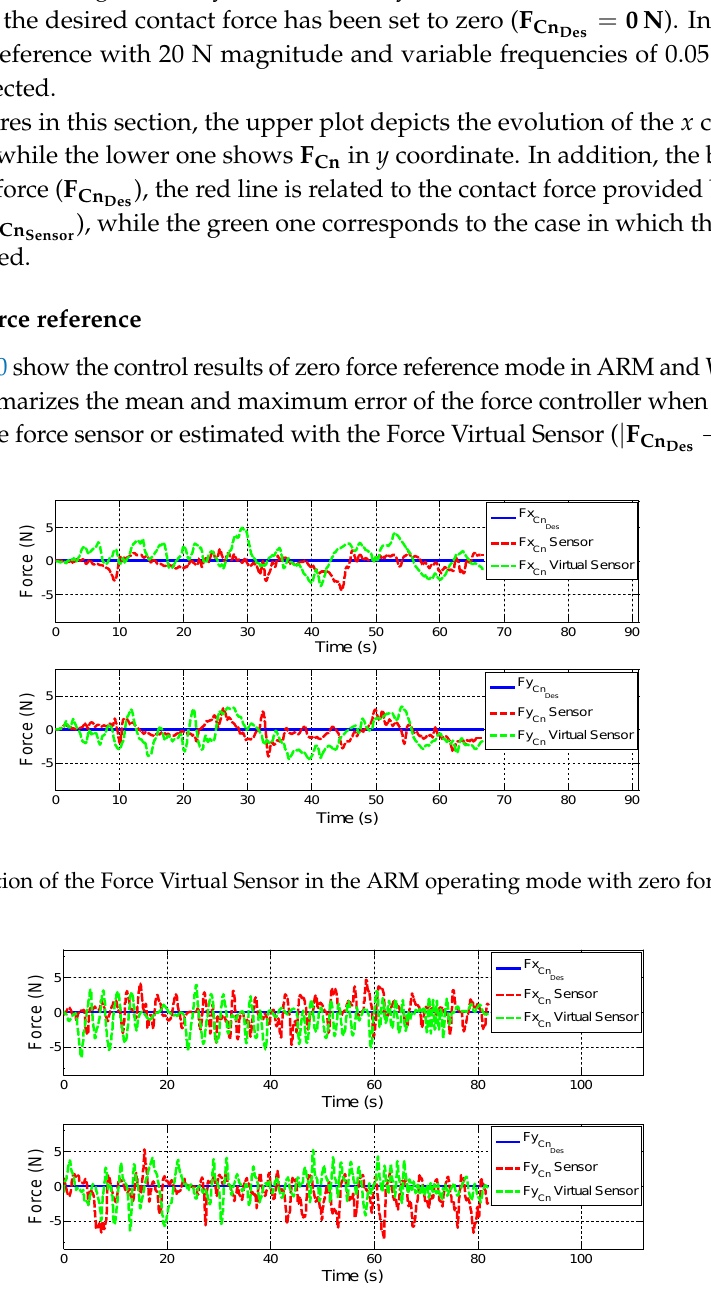
Figure 10. Validation of the Force Virtual Sensor in the WRIST operating mode with zero force